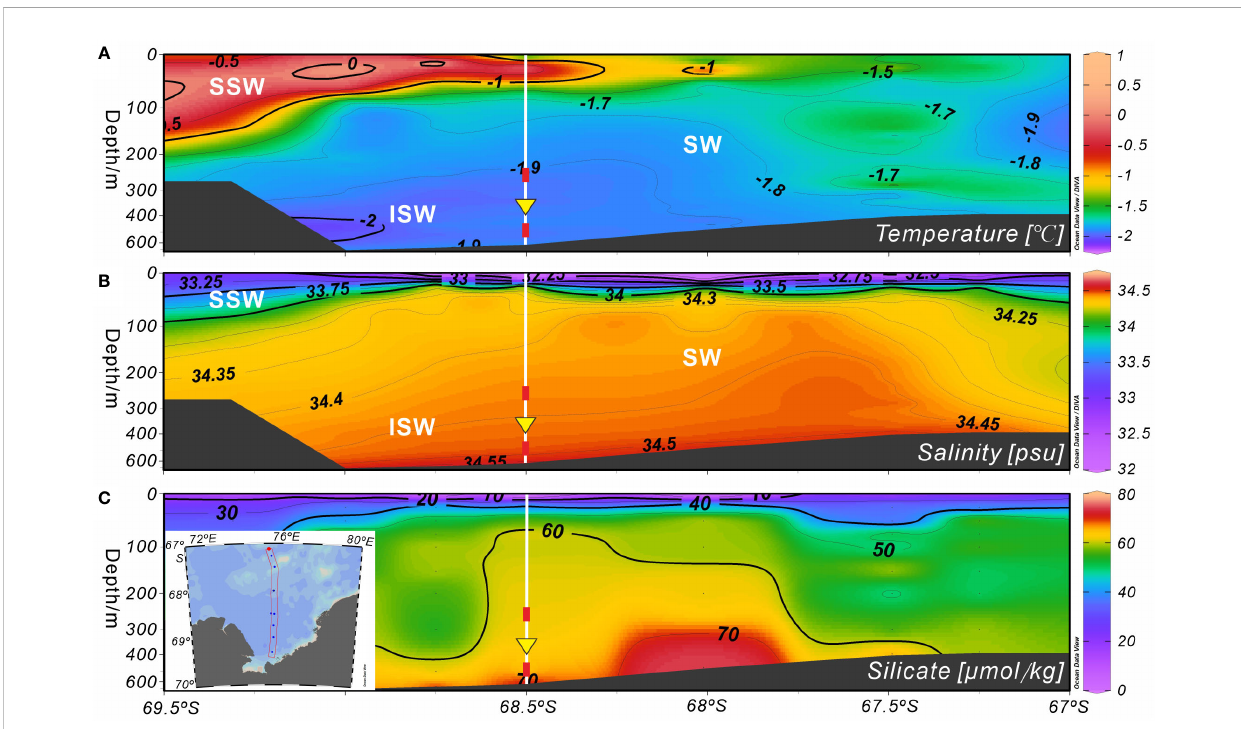
FIGURE 7 Marine environmental pro fi les of Section 75.5°E on the shelf of Prydz Bay in late summer 2015. (A, B) Temperature and salinity pro fi les showing the locations of water masses. (C) Silicate pro fi le. Major water masses: SSW, Summer Surface Water; SW, Shelf Water; ISW, Ice Shelf Water. White vertical solid lines indicate the location of Station M8, red rectangles mark the depths of the temperature sensors, and yellow inverted triangles indicate the position of the sediment trap. The data set was provided by the National Arctic and Antarctic Data Center (http://www.chinare.org.cn), and was obtained during the 31 st cruise of CHINARE from February 28 to March 1,